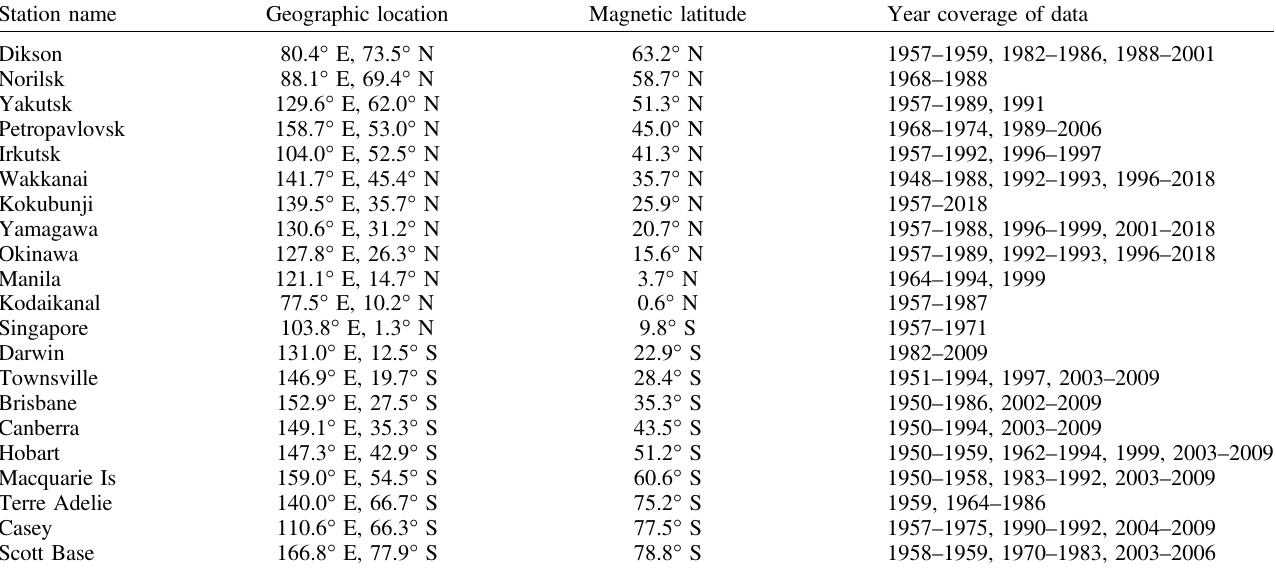
Table 1. Information of the ionosonde stations and